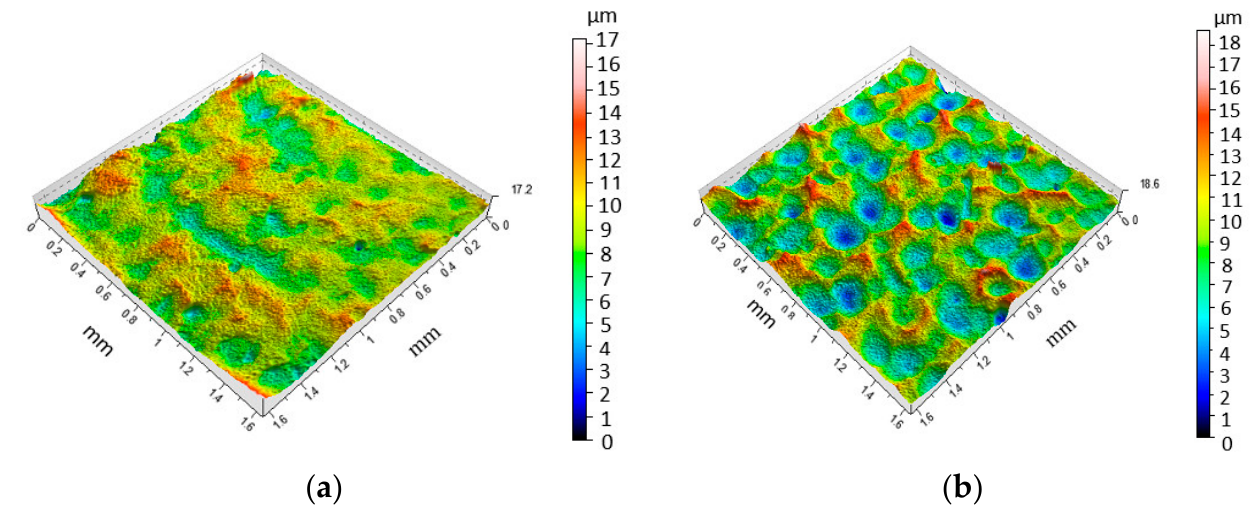
Figure 4. Three-dimensional roughness topography for variant 10 (specimen after TIG welding) in the ( a ) FZ and ( b ) BM.